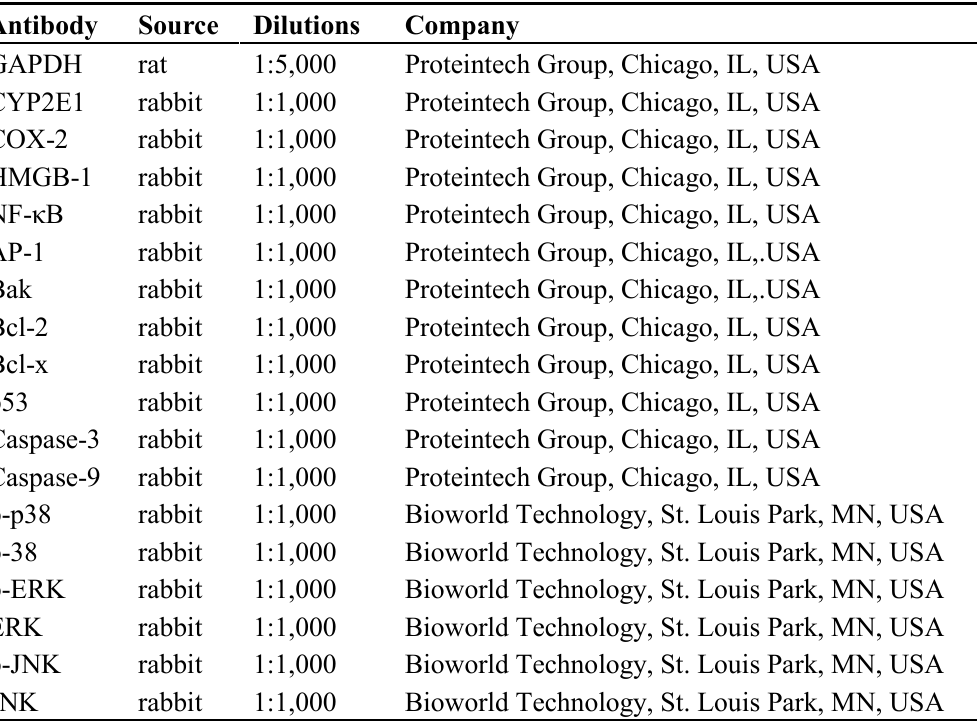
Table 1. The antibodies used in the present